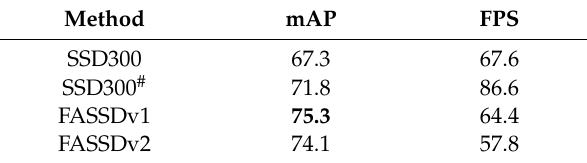
Table 6. Results and inference speed with LAKE-BOAT.